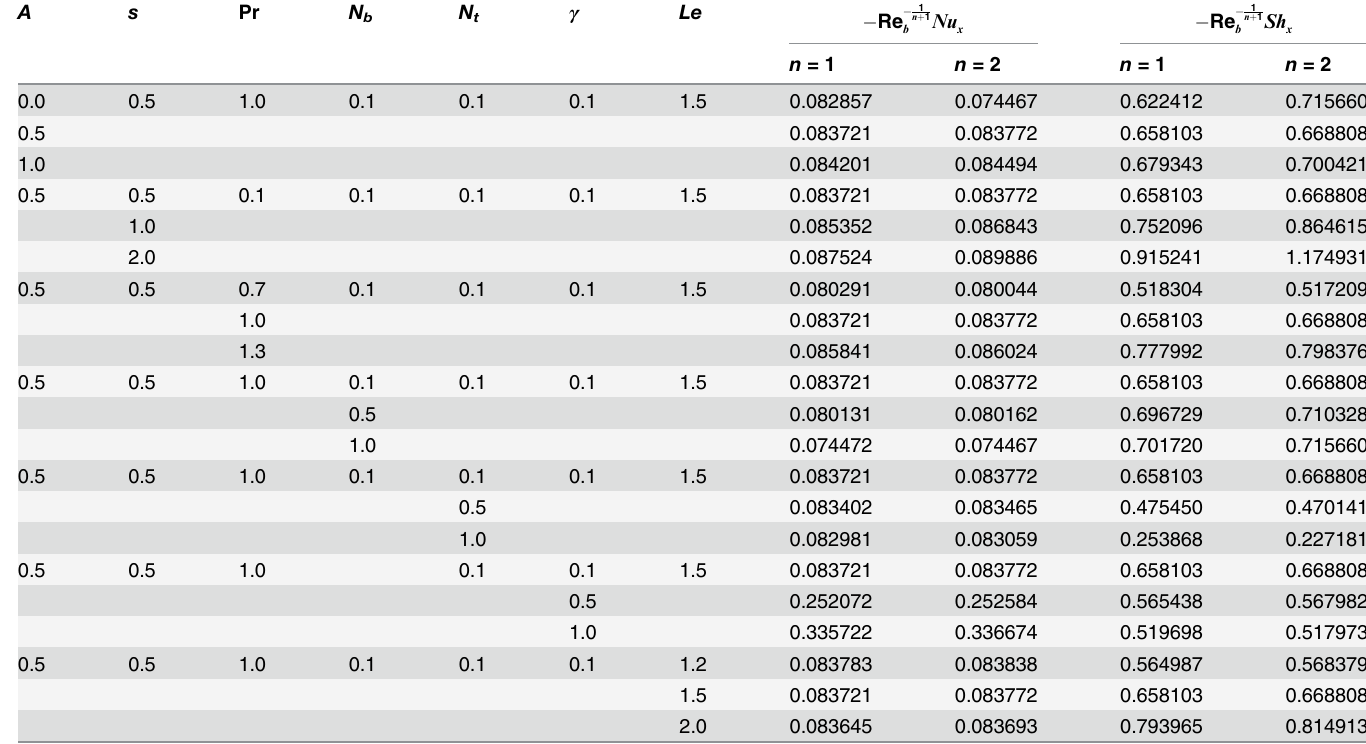
1 n þ 1 b Sh x for different values of emerging physical